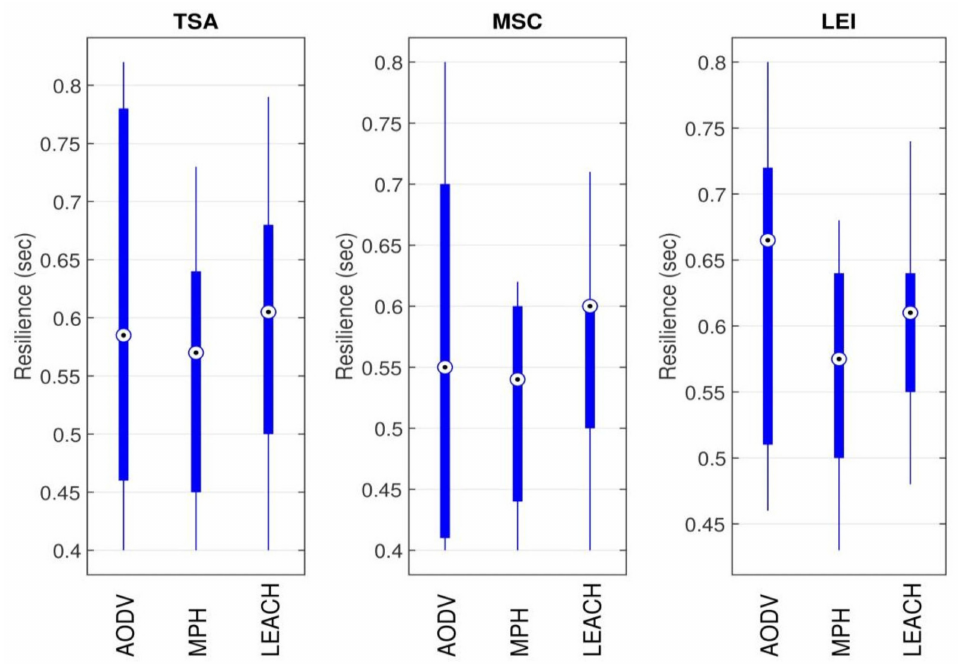
Figure 16. Resilience for the studied sleeping techniques and protocols under LoRa